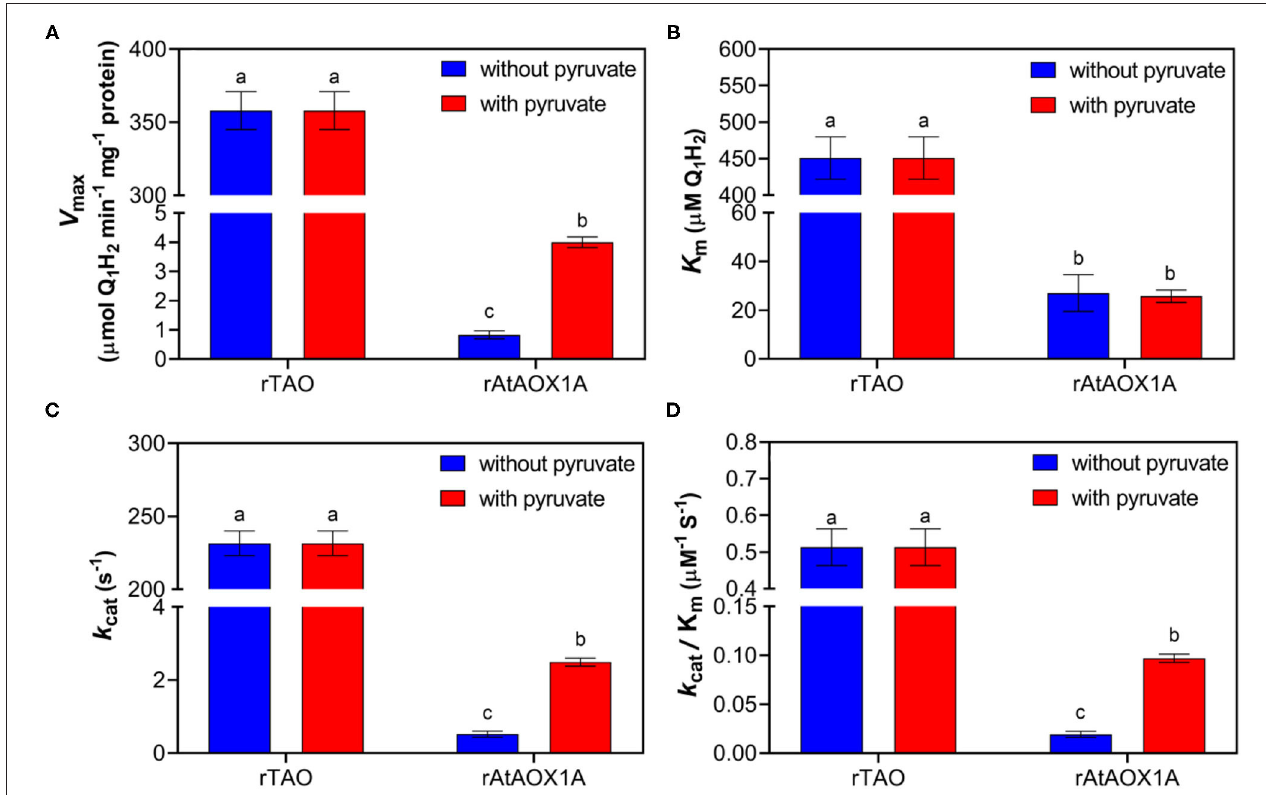
FIGURE 3 | Quinol assay of purified rTAO and rAtAOX1A. The specific activity of purified rTAO and rAtAOX1A were measured spectrophotometrically (A) . The kinetic parameters were compared between rTAO and rAtAOX1A, including K m (B) , k cat (C) , and k cat / K m (D) . Assays were performed in 150 µ l MOPS buffer pH 7.5 with different concentrations of quinol-1 as the substrate, with the change in absorbance at 278nm measured to determine the rate of quinol conversion. In addition, the activities of rTAO and rAtAOX1A with ( + ) or without (–) 10mM pyruvate during purification were compared in this experiment. Results are an average of at least three separate preparations. The significant difference p < 0.05 was marked as different